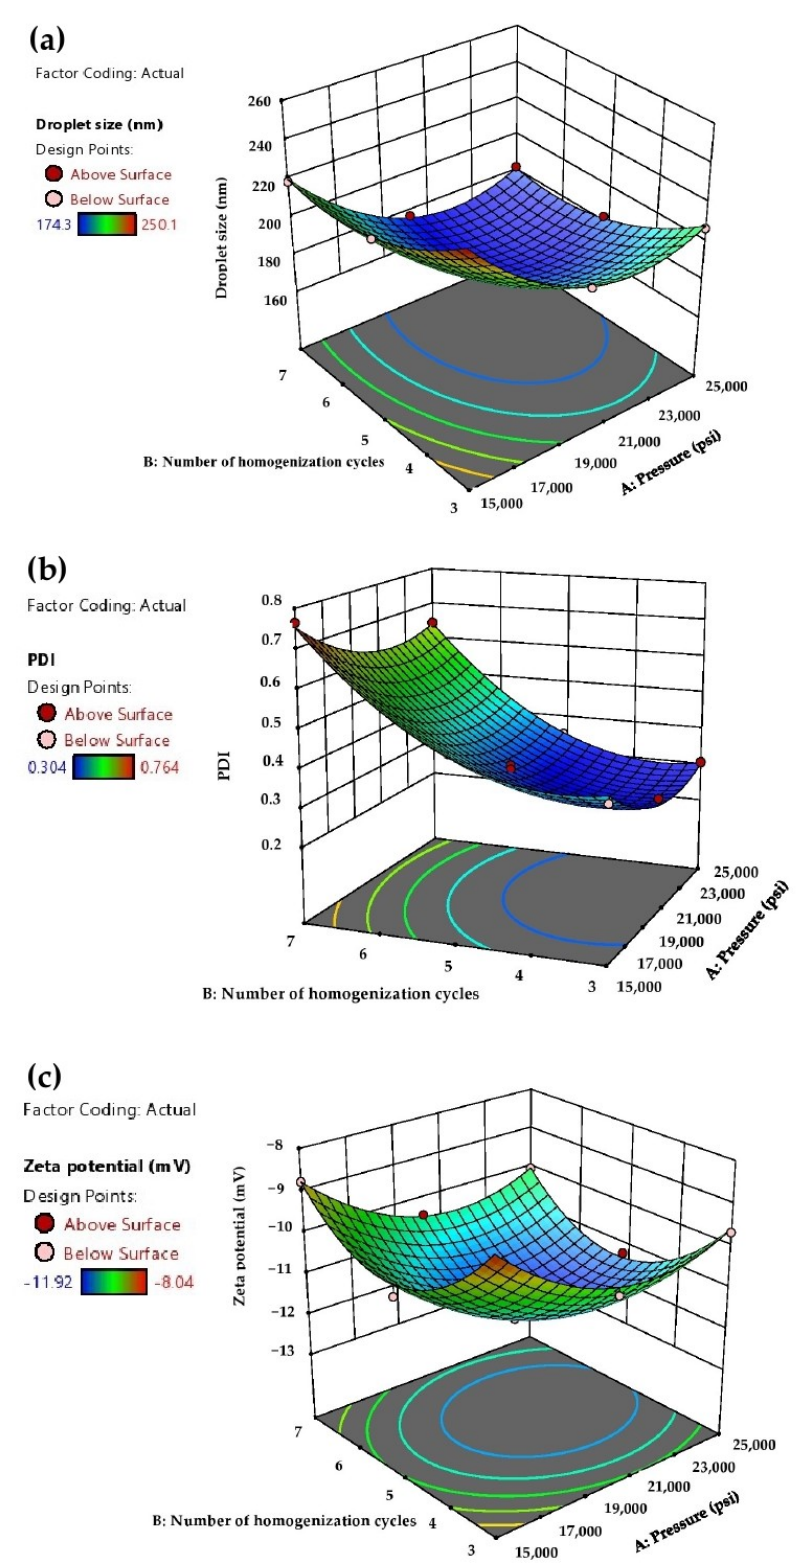
Figure 1. Response surface plots of the effect of pressure and number of homogenization cycles on the responses: ( a ) droplet size, ( b ) PDI and ( c ) zeta potential of AG-NEs.